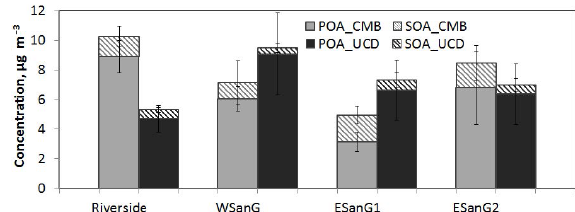
Figure 3. POA and SOA concentrations estimated by the CMB method (left gray columns) and predicted by the UCD/CIT model (right dark columns). Error bars represent the standard deviation of concentrations estimated during the sampling periods by both meth- ods. The uncertainties of CMB-derived SOA range from 1 to 22% (Daher et al., 2012). The data are for sampling periods in 2005– 2007 at four sites in Southern California.